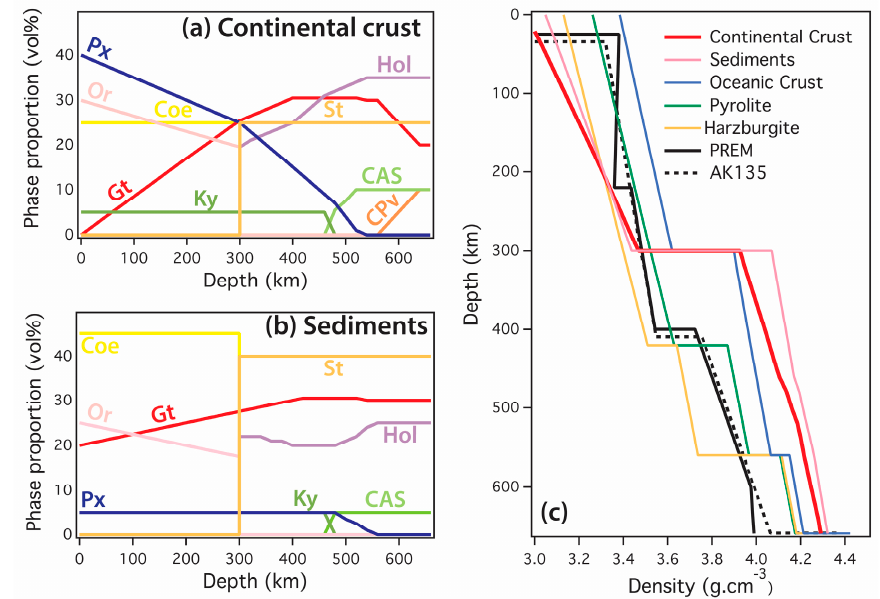
Figure 7. Phase proportions in ( a ) continental crust and ( b ) sediment as a function of depth, derived from Irifune et al. [4]. ( c ) Calculated density of continental crust and sediment as function of depth compared to that of other mineralogical models of pyrolite, oceanic crust (mid-ocean ridge basalt), and harzburgite, and global seismic models PREM [39] and AK135 [40]. Abbreviations: Px, pyroxene; Or, orthoclase; Coe, coesite; Gt, garnet; Ky, kyanite; St, stishovite; Hol, hollandite; CAS, Ca-rich aluminosilicate phase; CPv, CaSiO 3 perovskite.